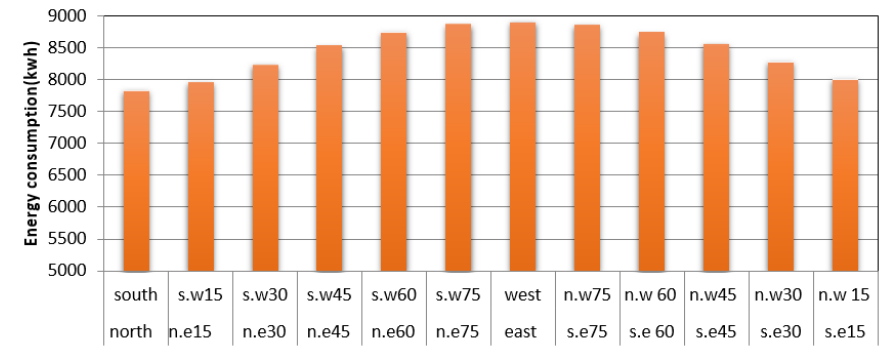
Figure 6. Total energy consumption in all two interfaces opposite annually